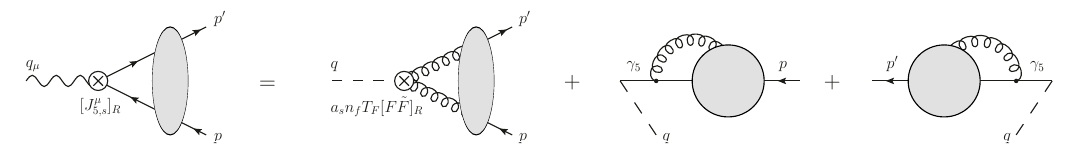
Figure 1 . An illustration of the anomalous Ward-Takahashi identity (3.1). The first diagram on the r.h.s. is only one of three types of contributions, while the other two involve a local vertex with either three gluons or two quarks as implied by eqs. (2.8) and